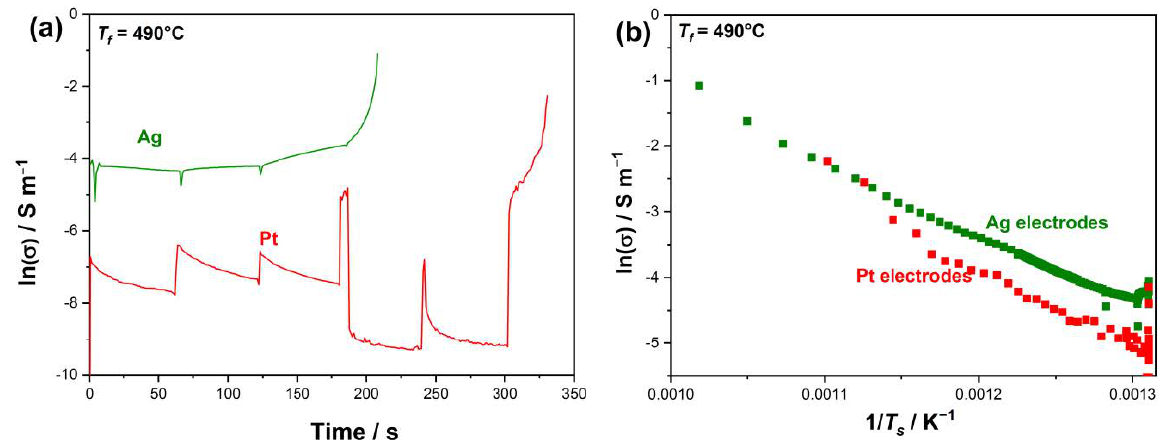
Figure 5. ( a ) Logarithm of conductivity as a function of time for the samples treated at 490 ◦ C. ( b ) The logarithm of conductivity as a function of 1/T for the samples treated at 490 ◦ C.